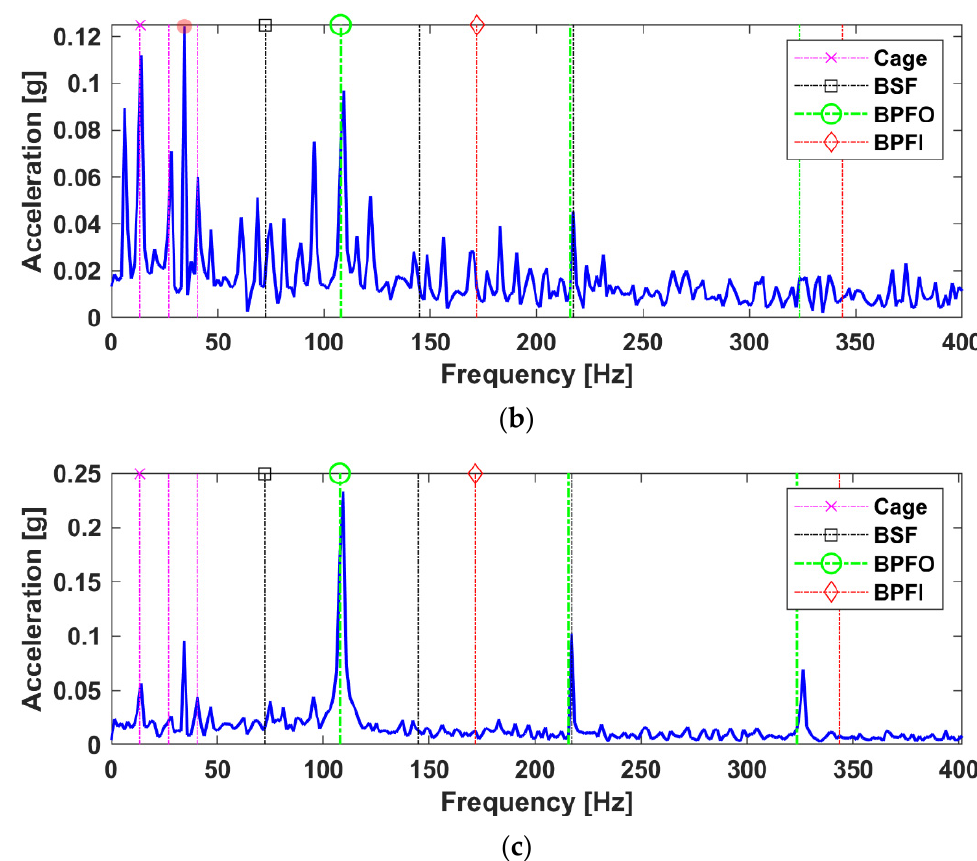
Figure 20. ( a – c ): Results based on the cross-power spectral density of the two-channel envelope signals, from Case A to Case C.